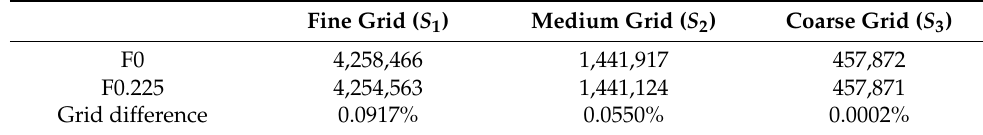
Table 3. Total grid number for different grid